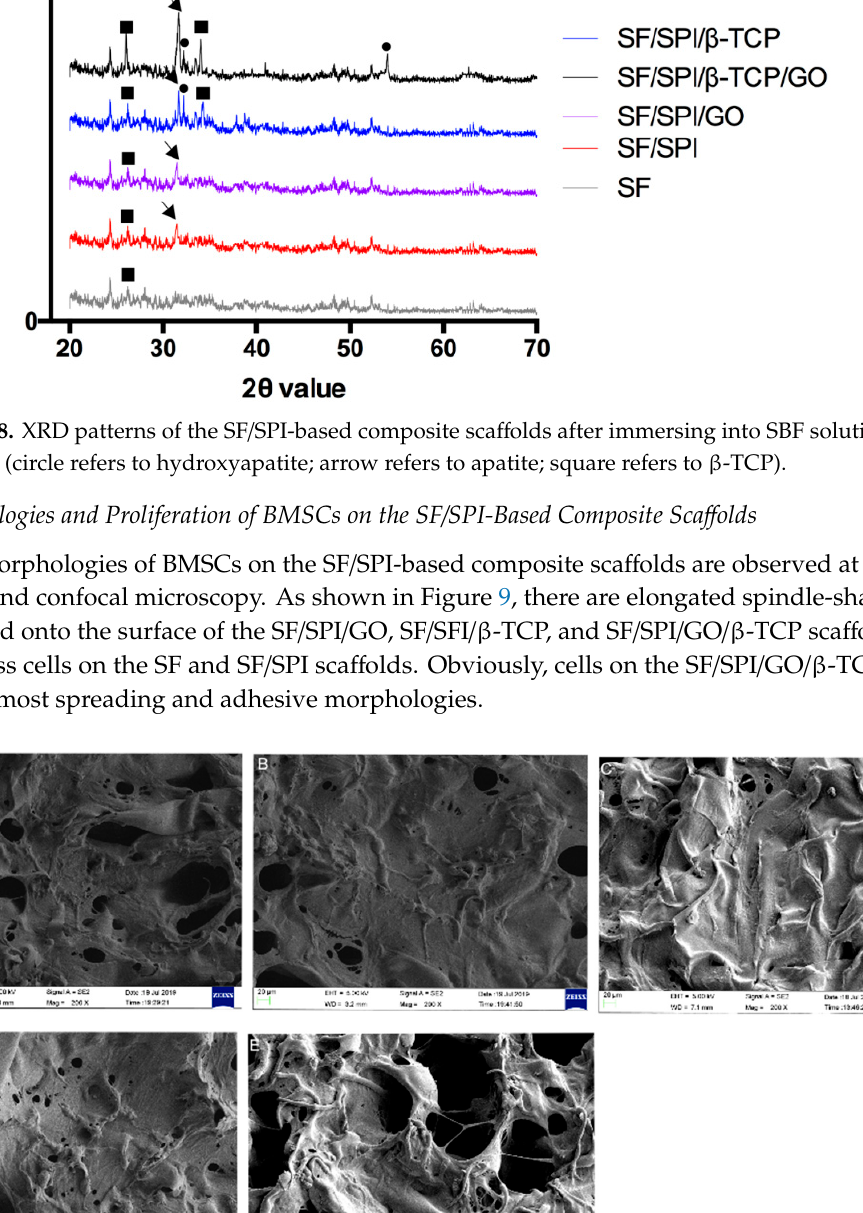
Figure 7. Field emission scanning electron microscope (FESEM) photographs of the SF/SPI-based composite scaffolds after immersing into simulated body fluid (SBF) solution at different time points. As shown in Figure 8, the XRD patterns after incubation in SBF solution for 14 days display the characteristic peaks corresponding to apatite at 26.0° (002) and 31.77° (211) (JCPDS 9432 card), which confirm the nucleation of hydroxyapatite (HA) in all the samples. Extremely weak peak at 26.0° is observed on SF scaffold, indicating small amount and low crystallinity of apatite formed. The SF/SPI